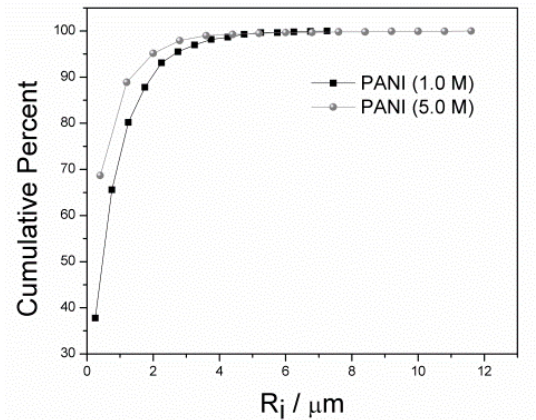
Figure 5. Cumulative percentage of particles from PANI (1.0 M) and PANI (5.0 M) samples calculated on the basis of the images presented in Figure 4a,b; R i is the maximum radius of a circle inscribed into a